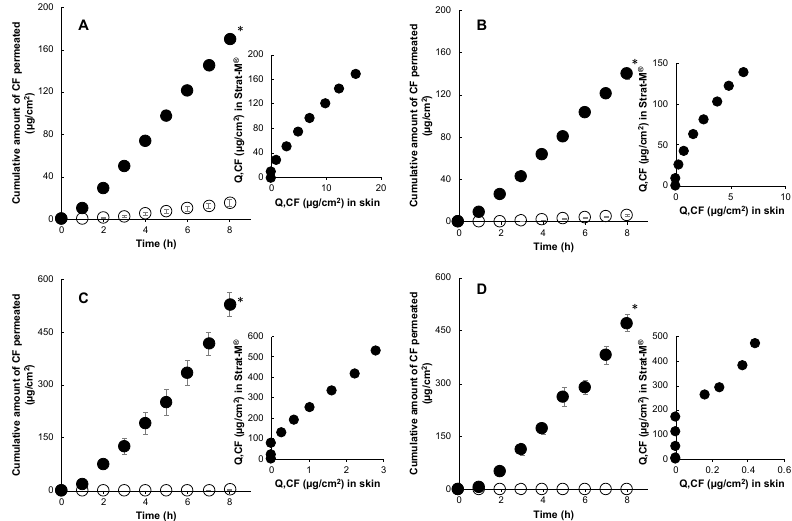
Figure 4. Time course of the cumulative amount of CF that permeated through Strat-M ® ( • ) and porcine skin ( ○ ) and their correlations under infinite dose conditions. 1% CF in water ( A ), 1% CF in 50% polyol ( B ), 1% CF in 75% polyol ( C ), and 1% CF in 100% polyol ( D ). Each point represents the mean ± S.E. ( n = 4). There was a significant difference (* p < 0.05) between RD permeation through Strat-M ® and porcine skin.